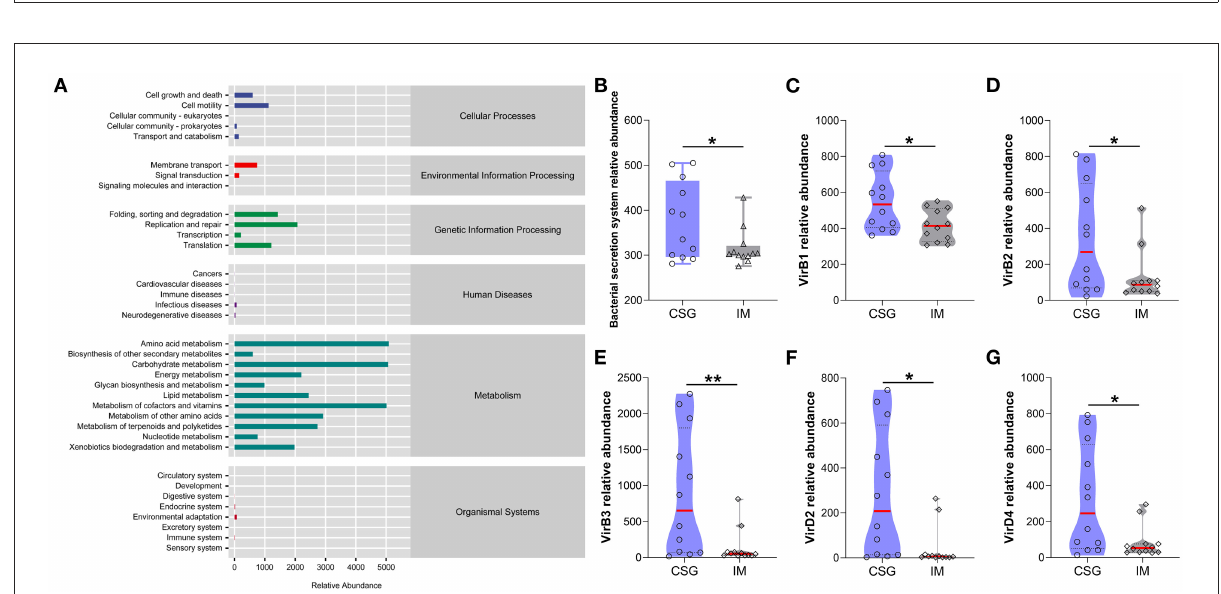
FIGURE5 Analysis of KEGG metabolic pathway difference of gastric juices microbiota in patients with CSG and IM. (A) Total KEGG metabolic pathway. (B) Relative abundance of bacterial secretion system between the gastric juice microbiota of CSG and IM patients. (C) VirB1 relative abundance between the gastric juice microbiota of CSG and IM patients. (D) VirB2 relative abundance between the gastric juice microbiota of CSG and IM patients. (E) VirB3 relative abundance between the gastric juice microbiota of CSG and IM patients. (F) VirD2 relative abundance between the gastric juice microbiota of CSG and IM patients. (G) VirD4 relative abundance between the gastric juice microbiota of CSG and IM patients. Asterisks denote significance (* p < 0.05; ** p < 0.01).